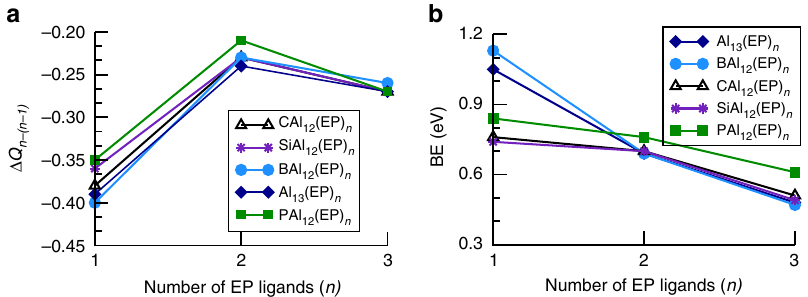
Fig. 4 The effect of ligands on Al and doped Al clusters. a Accumulated charge and b Ligand-binding energies in Al 13 (EP) n and MAl 12 (EP) n (M = B, C, Si, and P) clusters where n = 1 –